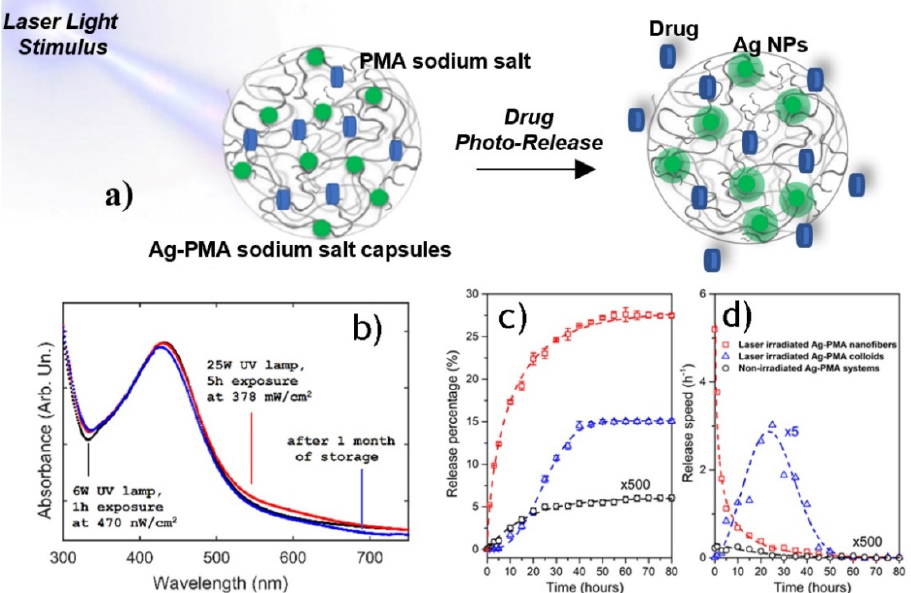
Figure 7. ( a ) Schematic representation of laser light inducing drug release from Ag-PMA sodium salt capsules. ( b ) UV-vis optical absorbance spectra of Ag-PMA sodium salt capsules at different UV irradiation treatments (black and red line) and after one month of storage (blue line) t. ( c ) The release percentage vs time and the corresponding best-fit performed using Weibull function (dashed lines). ( d ) The release speed as the Weibull derivative; some data are multiplied by the indicated factor for clarity. Adapted from Ref. [85,86].